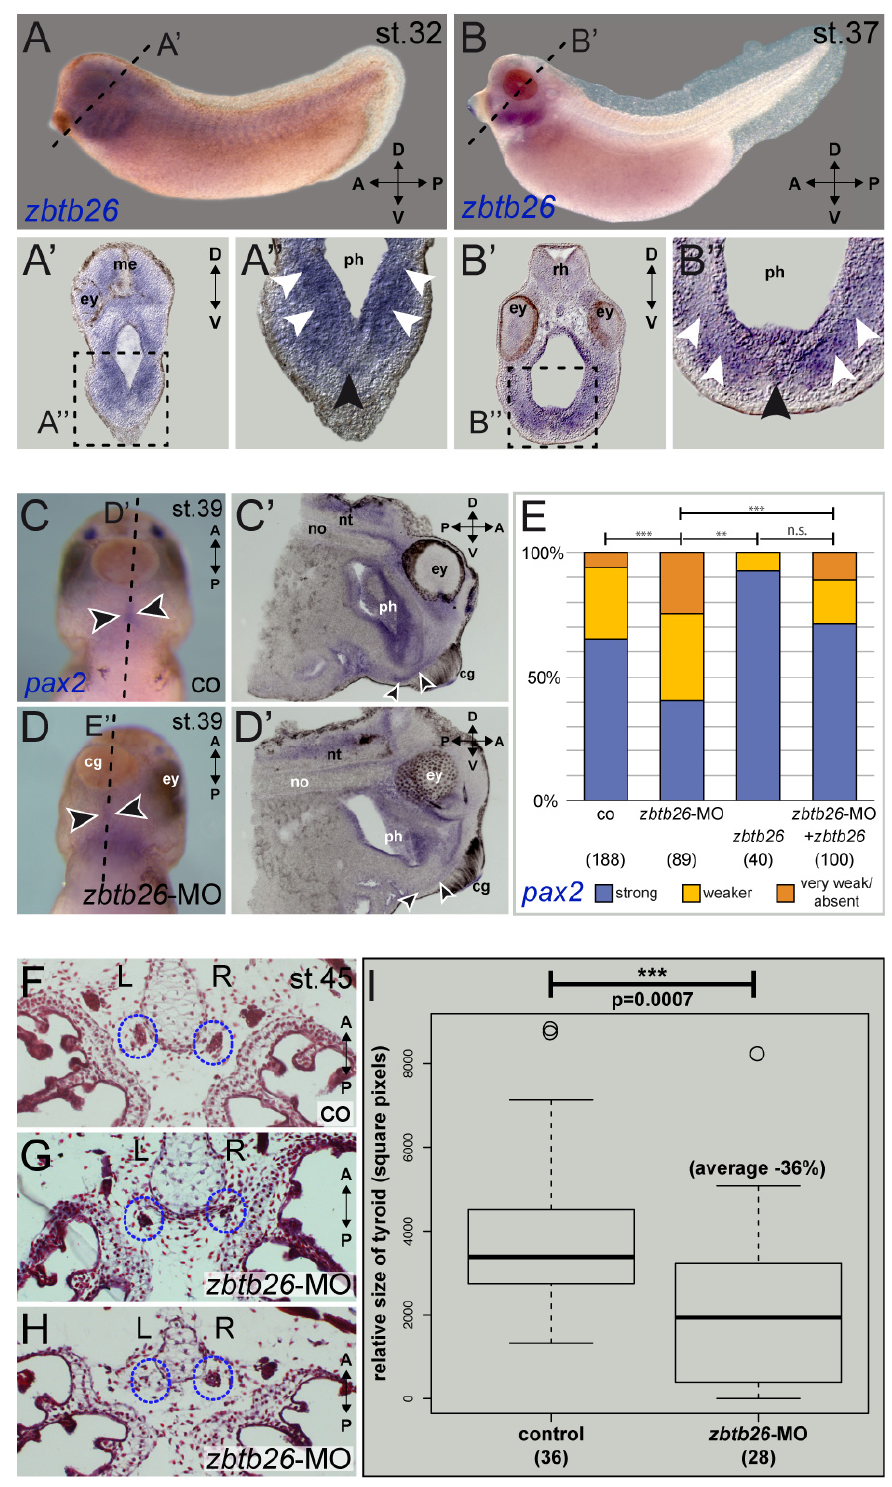
Figure 2. zbtb26 has a conserved role in amphibian thyroid development. ( A , B ) Developmental expression of zbtb26 mRNA in the thyroid anlage of the frog X. laevis . Transcripts in the head are detected ventrally in the medial (( A , B’’ ), black arrowheads) and ventro-lateral pharyngeal mesenchyme (white arrowheads) of stage 32 ( A , A’’ ) and stage 37 ( B , B’’ ). Plane of sections in ( A’ , B’ ) are indicated by dashed lines in ( A , B ); magnified areas in ( A’’ , B’’ ) are indicated by dashed boxes in ( A’ , B’ ). ( C – E ) pax2 expression in the thyroid anlage of stage 39 embryos is reduced by zbtb26 knockdown. Thyroid anlage is highlighted by arrowheads. zbtb26 -MO-injected specimens showed reduced or lost expression of pax2 in the thyroid ( D , D’ , E ) compared to control embryos ( C , C’ , E ). This could be rescued by co-injection of full-length zbtb26 mRNA ( E ). Please note apparently more